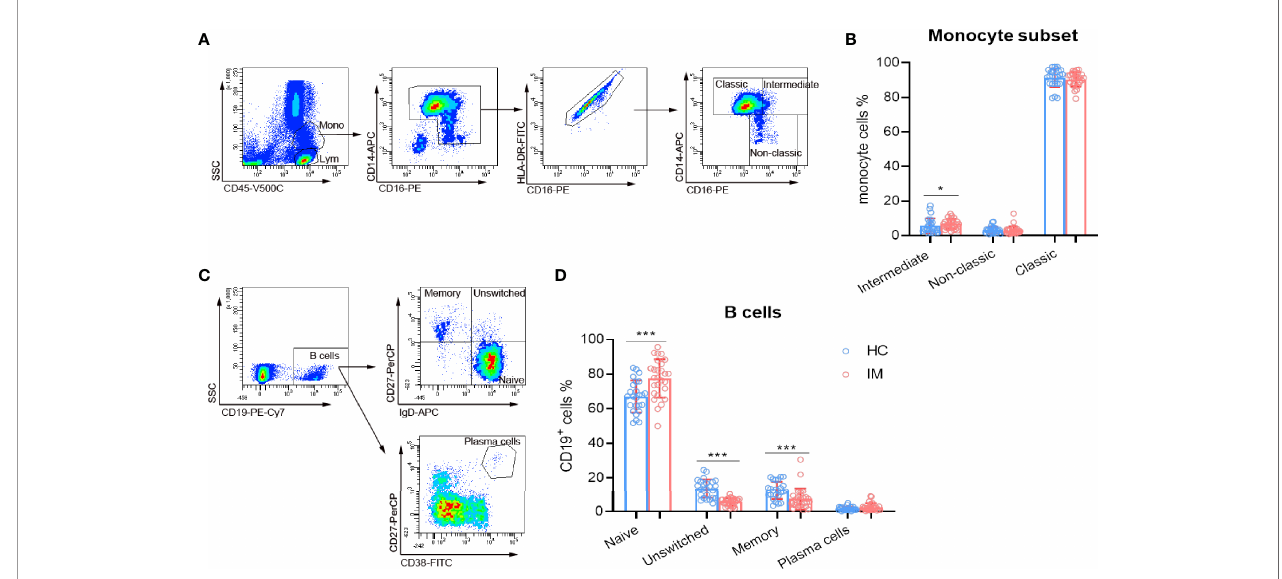
FIGURE 4 | The subsets of monocytes and B cells. (A) Representative monocyte gating strategies in whole blood. CD45 vs. SSC plot: Broad selection of monocytes based on their SSC/CD45 properties. CD14 vs. CD16 plot: Gating to select monocytes based on their characteristic “ ┐ ” shape. CD16 vs. HLA-DR plot: Gating to select HLA-DR positive cells and remove NK cells. Selected monocytes redisplayed on CD16 vs. CD14 plot to gate the classical (CD14 ++ CD16 – ), non- classical monocyte (CD14 + CD16 + ), and intermediate (CD14 ++ CD16 + ) subsets. (B) The percentages of intermediate, non-classic, and classic monocytes from IM patients and HCs were expressed as mean and SD. (C) Representative fl ow dot plots showing the gating strategies of B cell subsets. CD19 + cells were gated and subclassi fi ed into Naïve (IgD + CD27 − ), unswitched (IgD + CD27 + ), and memory (IgD − CD27 + ) cell populations. Plasma cells were gated as CD27 + CD38 high cell population. (D) The percentages of B cell Naïve, unswitched, memory, and plasma cells from IM patients and HCs were expressed as mean with SD. Blue circle points represent HCs, and red circle points represent IM patients. * p < 0.05, *** p <